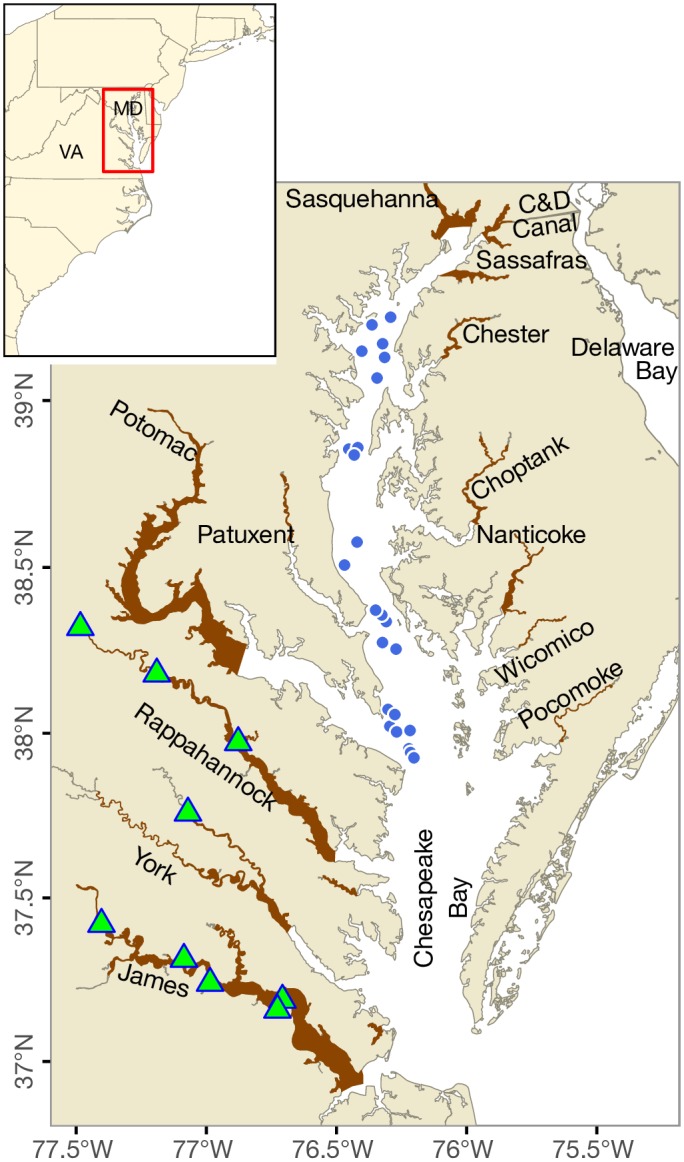
Stocking locations (green triangles, ▲) and current distribution of non-native blue catfish in Chesapeake Bay.Blue dots (●) correspond to additional locations where blue catfish were collected from the mainstem of the Chesapeake Bay during 2018 and 2019 (total fish collected = 63). The Chesapeake and Delaware Canal (C&D Canal) connecting the Chesapeake Bay with the Delaware Bay is also shown. Note that blue catfish have not been recorded from the Delaware Bay yet. Inset shows the location of the Chesapeake Bay in relation to Virginia (VA) and Maryland (MD). Figure available in color online.